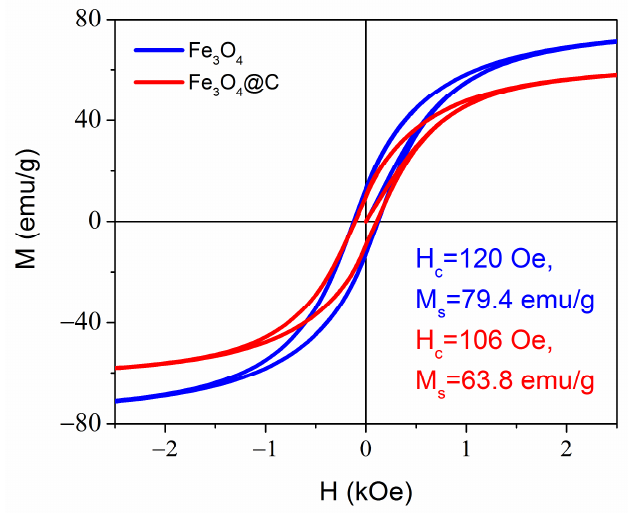
Figure 5. Room temperature magnetization curves for Fe 3 O 4 and Fe 3 O 4 @C NPs. The remnant magnetization M r = 12.7 emu/g and 9.7 emu/g for Fe 3 O 4 and Fe 3 O 4 @C NPs, respectively.